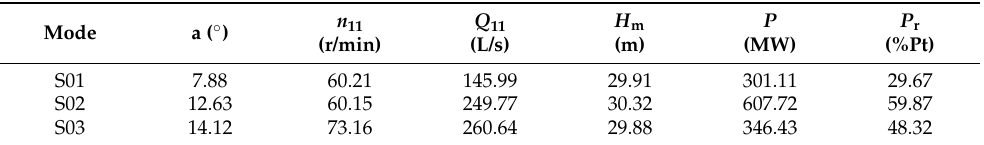
Table 2. Details of operating conditions.